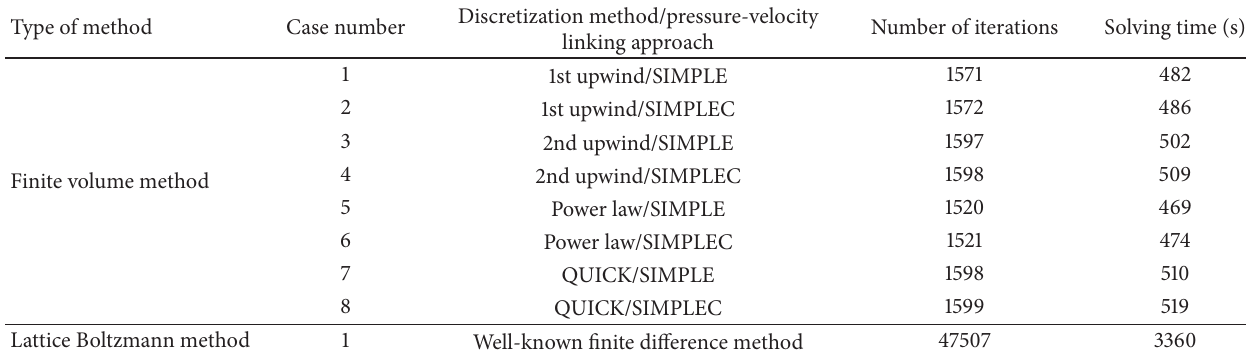
Table 5: Number of iterations and solving time for different discretization